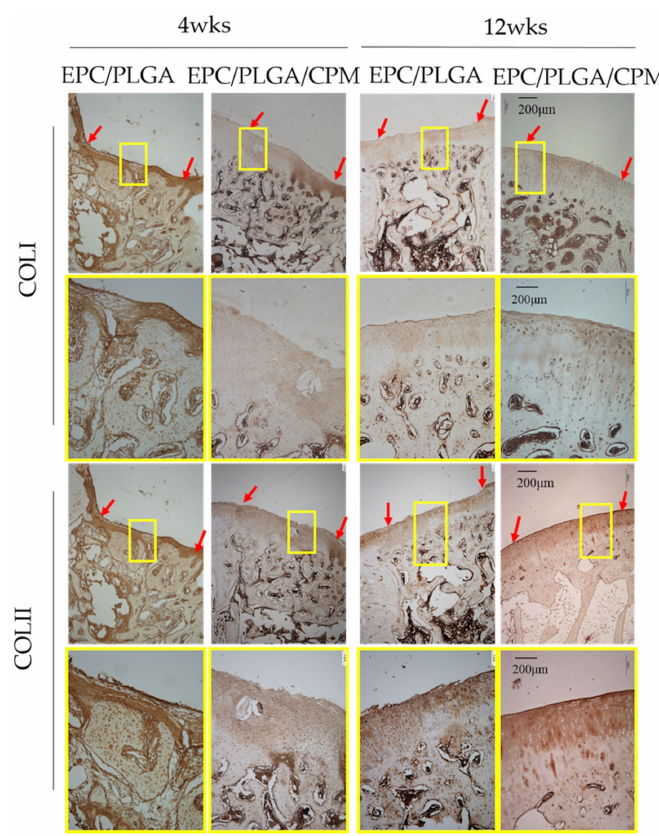
Figure 6. Representative images of specific proteins within the defect sites detected by Immunohistochemistry (IHC) staining. Four weeks after implantation, collagen type II (COLII) was present in the cartilage of the EPC/PLGA/CPM group. In the EPC/PLGA group, the PLGA scaffold was not degraded, and the surface was irregular. Twelve weeks after implantation, the COLII and collagen type I (COLI) staining were more distinctive in the EPC/PLGA/CPM group than in the EPC/PLGA group. A yellow square denotes the magnification scale. A red arrow shows the border of the repaired tissue. Scale bar 200 µ m.